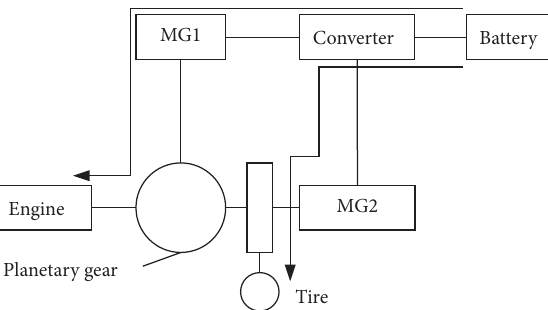
Figure 8: Power transmission of engine starting